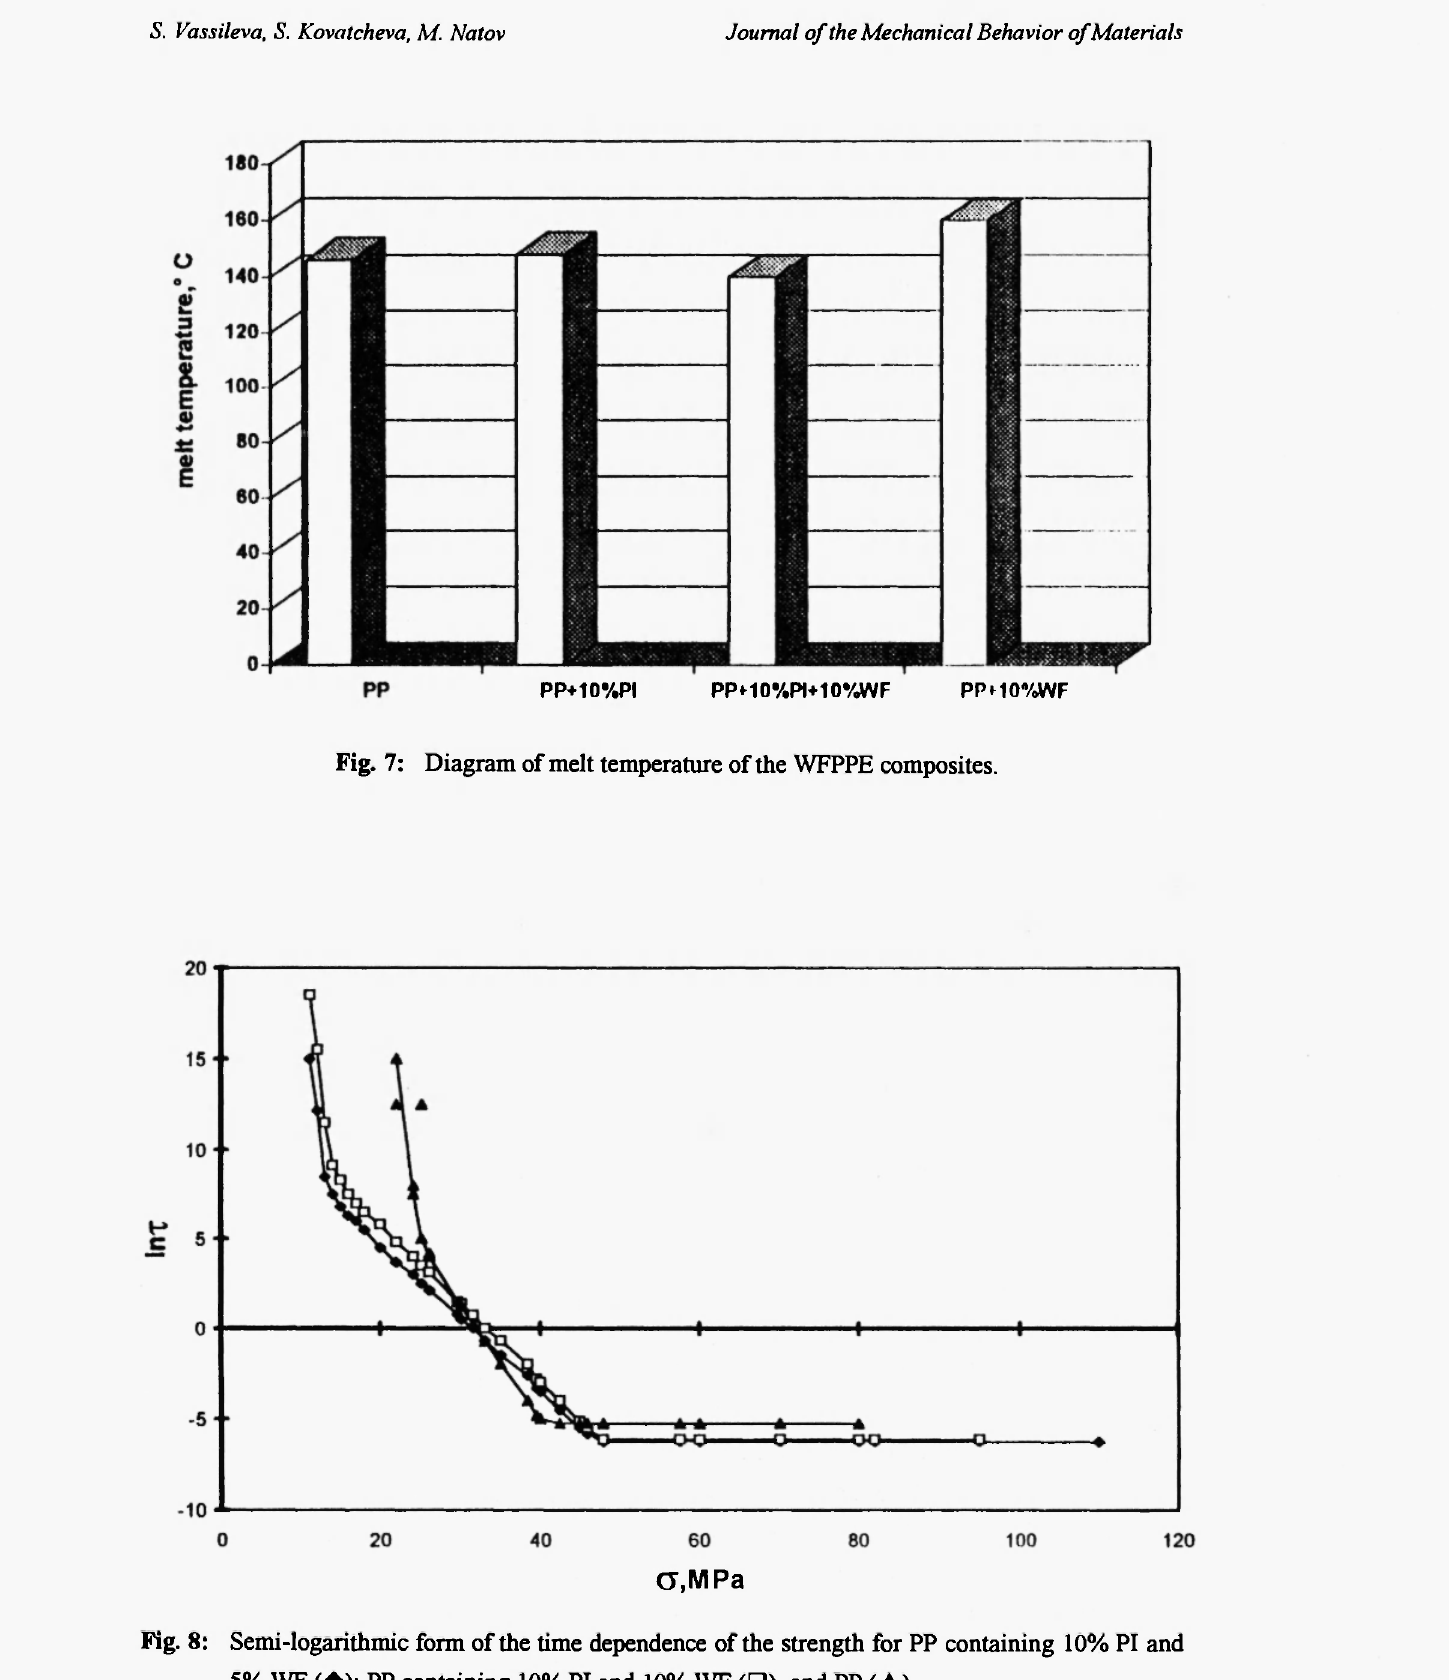
Fig. 8: Semi-logarithmic form of the time dependence of the strength for PP containing 10% PI and 5% WF (•); PP containing 10% PI and 10% WF (•), and PP (•).